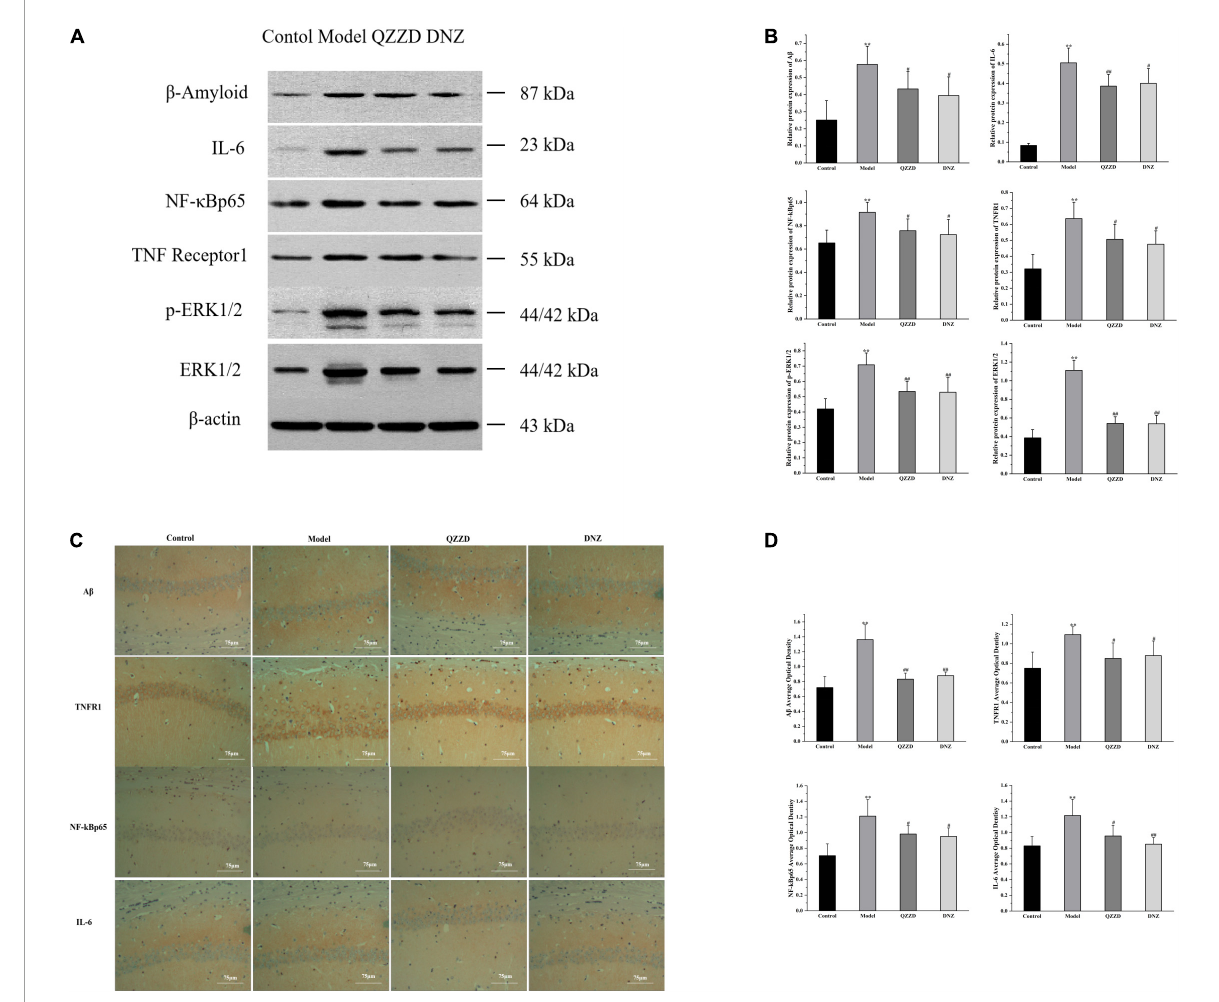
FIGURE11 Effects of QZZD on expressions of A β , IL-6, NF- κ Bp65, TNFR1, p-ERK1/2 and ERK1/2 in hippocampal tissues of APP/PS1 double transgenic mice with dementia. (A) Western blotting analysis showing the protein expression levels of A β , IL-6, NF- κ Bp65, TNFR1, p-ERK1/2 and ERK1/2 in the hippocampus. (B) Quantitative analysis of A β , IL-6, NF- κ Bp65, TNFR1, p-ERK1/2, and ERK1/2 protein bands. Values are expressed as the mean ± SD, n = 6 in each group. ** p < 0.01, compared with the control group; # p < 0.05, ## p < 0.01, compared with the model